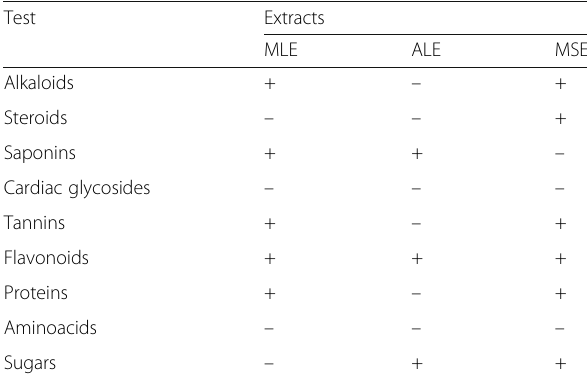
Table 1 Phytochemical constituents present in the extracts of different part of B. lupulina